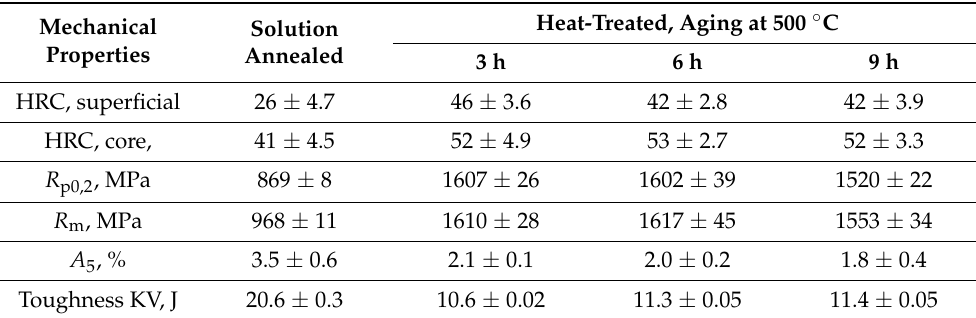
Table 5. Mechanical properties of the printed M789 maraging steel in solution annealed and heat- treated conditions (mean value, standard deviation).